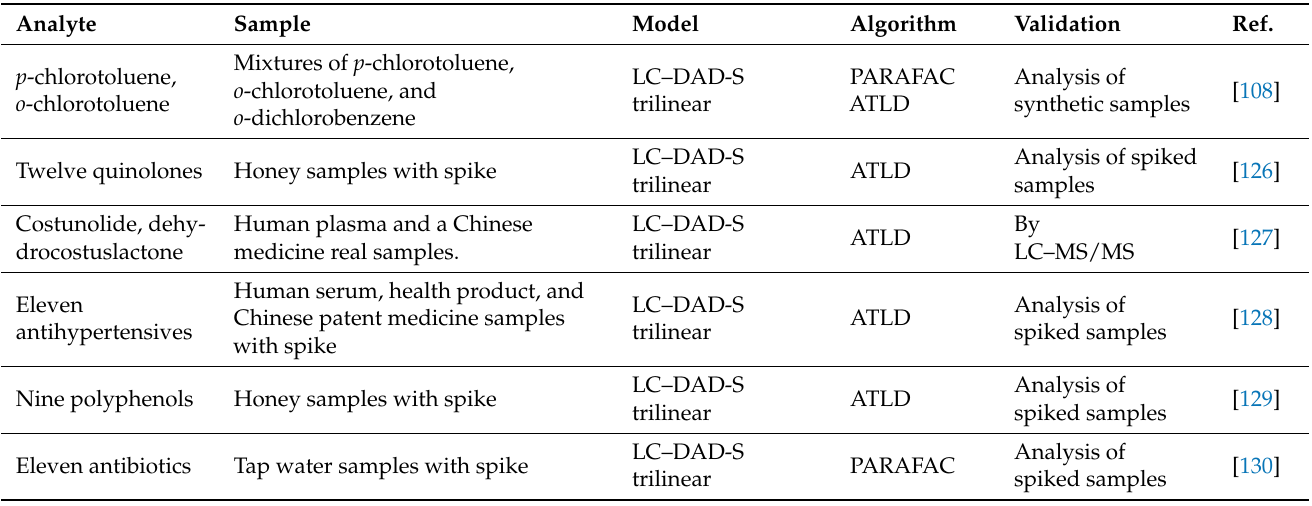
Table 1. Analytical applications of high-performance liquid chromatography–diode array detector (HPLC–DAD) assisted by three-way analysis based on the trilinear model. Model Algorithm Validation